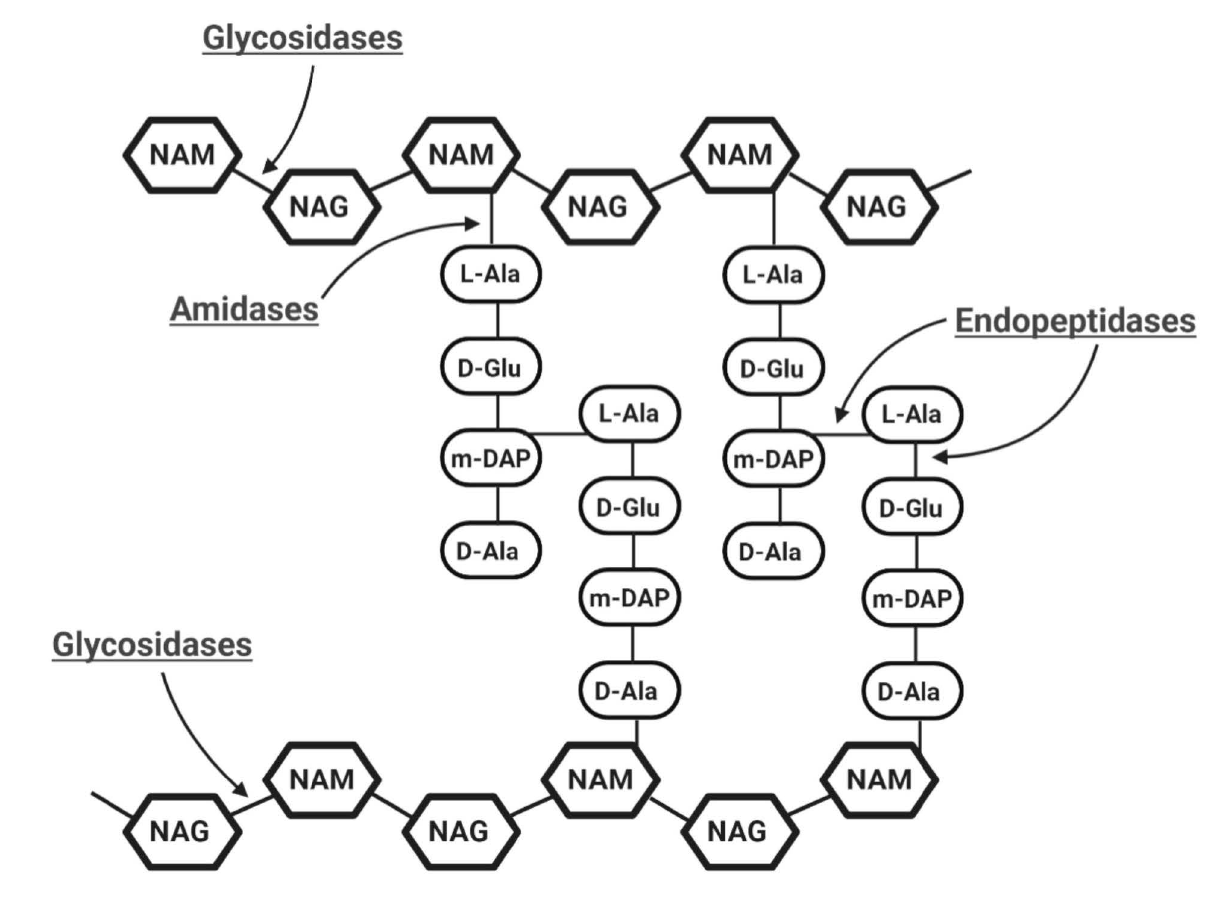
Figure 3. Schematic representation of the basic structure of bacterial cell wall peptidoglycan with possible catalytic activities of endolysins indicated. A sub-class of Glycosidases, N-acetyl- β -D-muramidases cleave the β -1,4 bonds between NAM (N-acetylmuramic acid) and NAG (N-acetylglucosamines), and N-acetyl- β -D-glucosidases cleave the β -1,4 bonds between NAG and NAM residues. N-acetylmuramoyl-L-alanine amidases which are amidases cleave the amide bonds between NAM and L-alanine. Endopeptidases cleave interpeptide and stem peptide–interpeptide